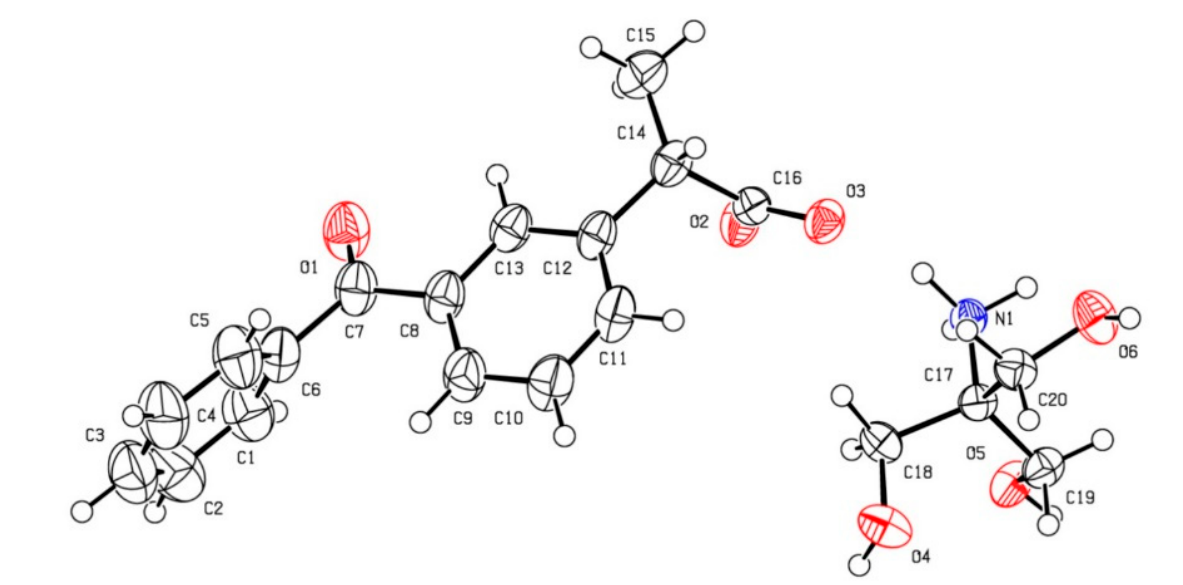
Figure 5. Thermal ellipsoid plot of a multicomponent crystal of ketoprofen and tromethamine (asymmetric unit; 50% probability level).